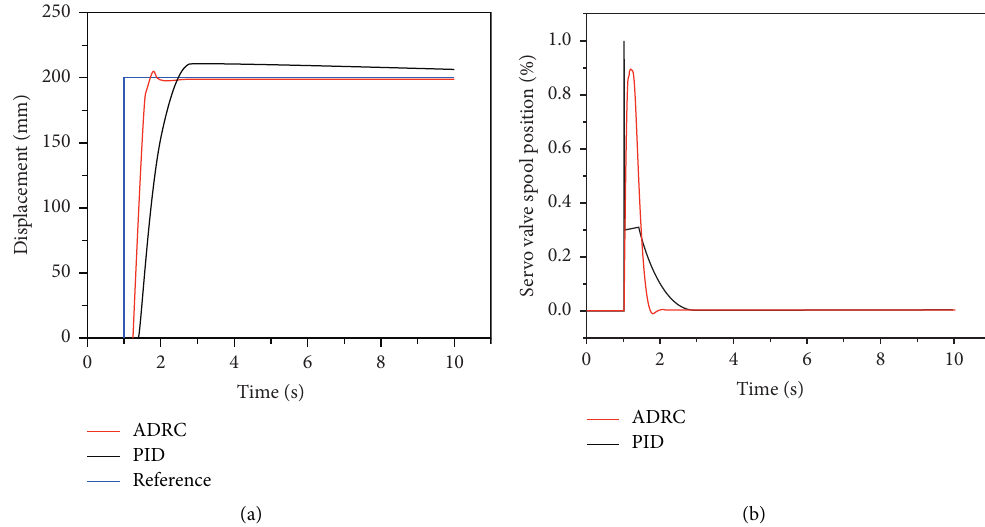
Figure 9: Step responses of the hydraulic system with long pipelines. (a) Cylinder displacement response. (b) Spool position